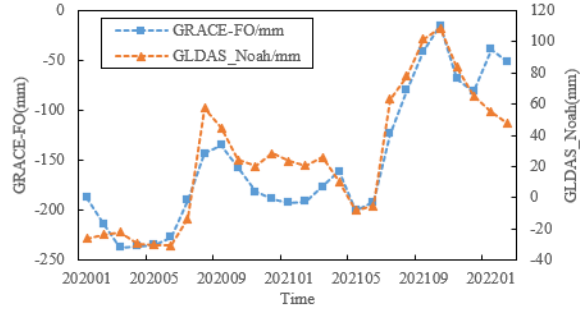
Figure 5. GRACE-FO Data Compared with GLDAS_Noah